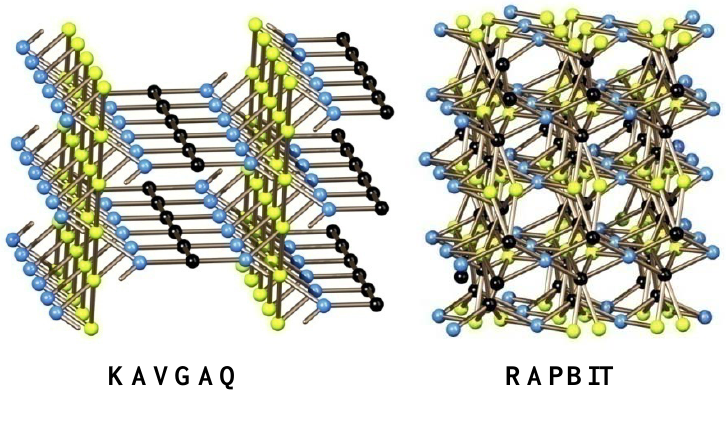
Figure 6. Topology of the 3-nodal three-dimensional